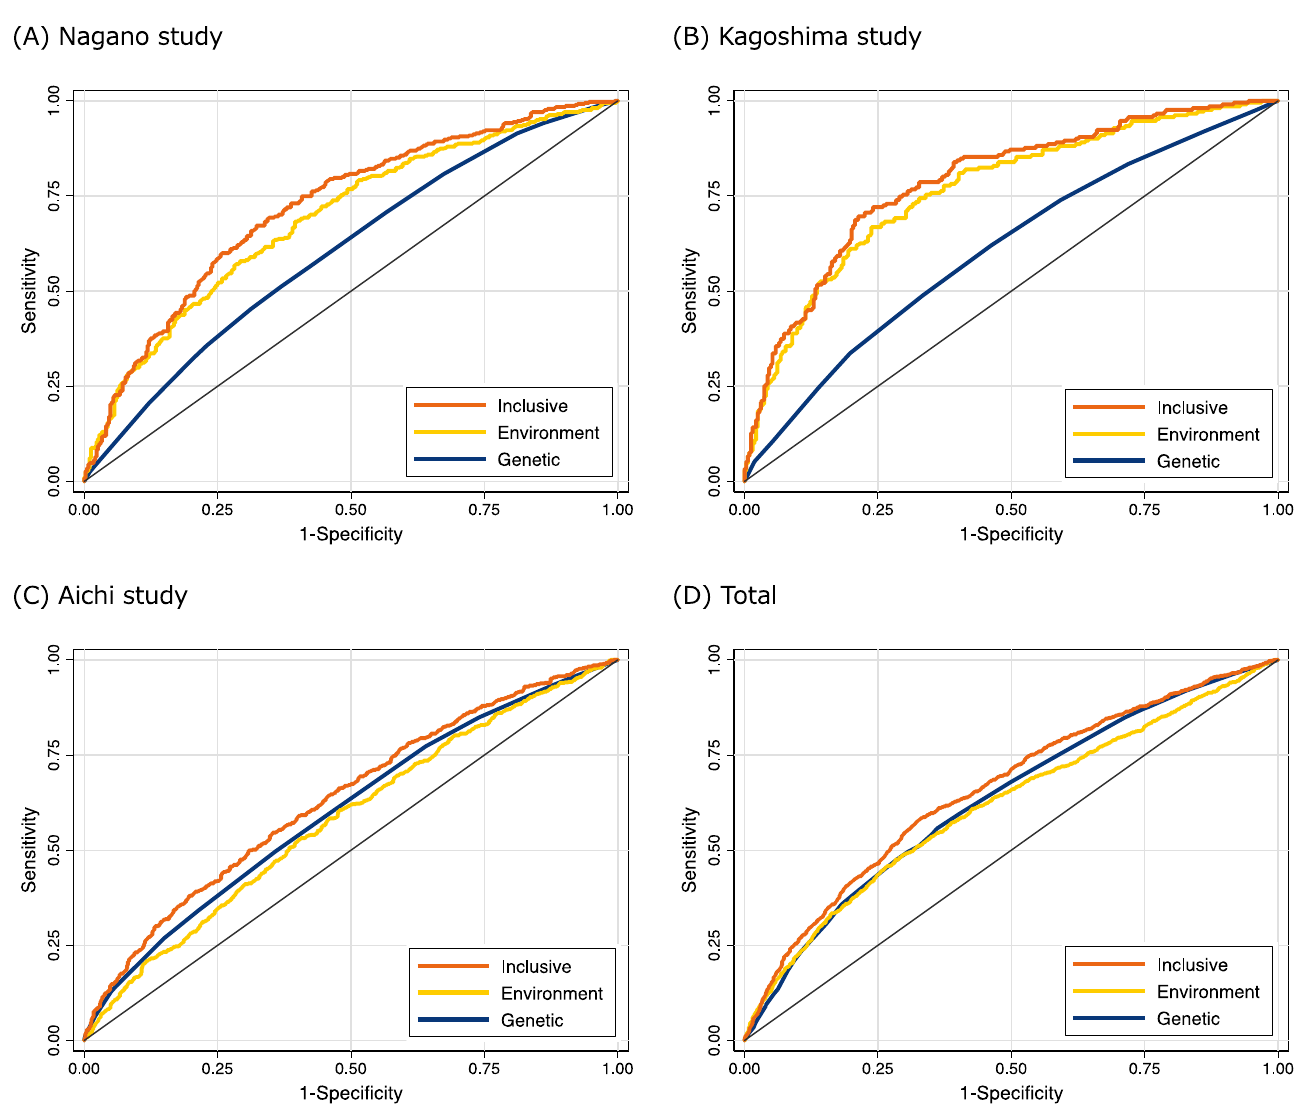
Figure 2. ROC curves of genetic, environmental and inclusive risk models in ( A ) Nagano study, ( B ) Kagoshima study, ( C ) Aichi study, and ( D ) total population. Orange, yellow and navy lines are ROC curves of the Inclusive, Environmental and Genetic models, respectively. Age, body mass index, ethanol drinking, cigarette smoking, physical activity, family history of breast cancer, age at menarche, parity, number of children, age at first delivery, breastfeeding, hormone therapy and menopausal status were adjusted in the Environmental model. Table 3. C-statistics of genetic, environmental and inclusive risk models.